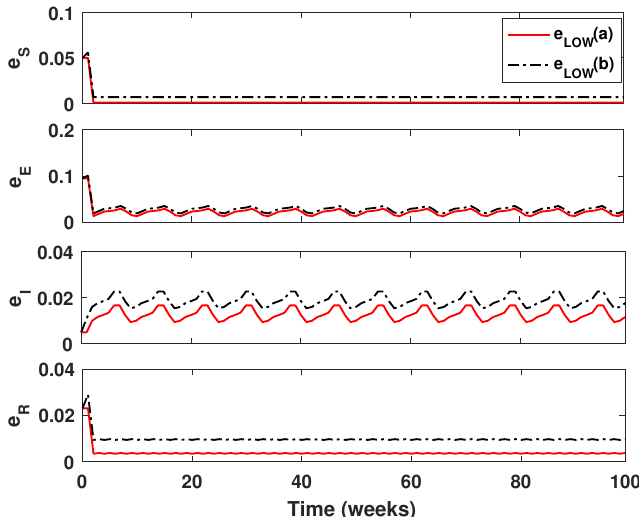
Figure 3. Upper-bound error: (a) proposed method; (b) method given in [28].